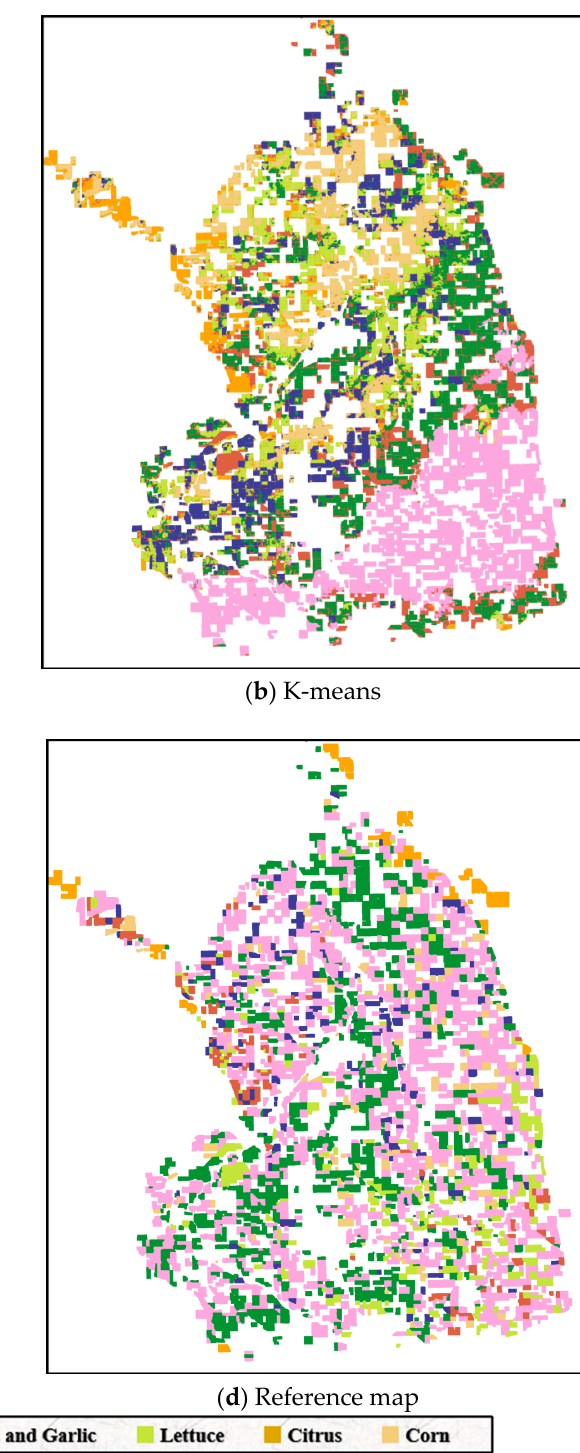
Figure 14. Clustering maps of the Imperial Dataset were produced using different methods with averaged initial cluster centers. ( a ) FAISS; ( b ) K-means; ( c ) DTIC; ( d ) reference